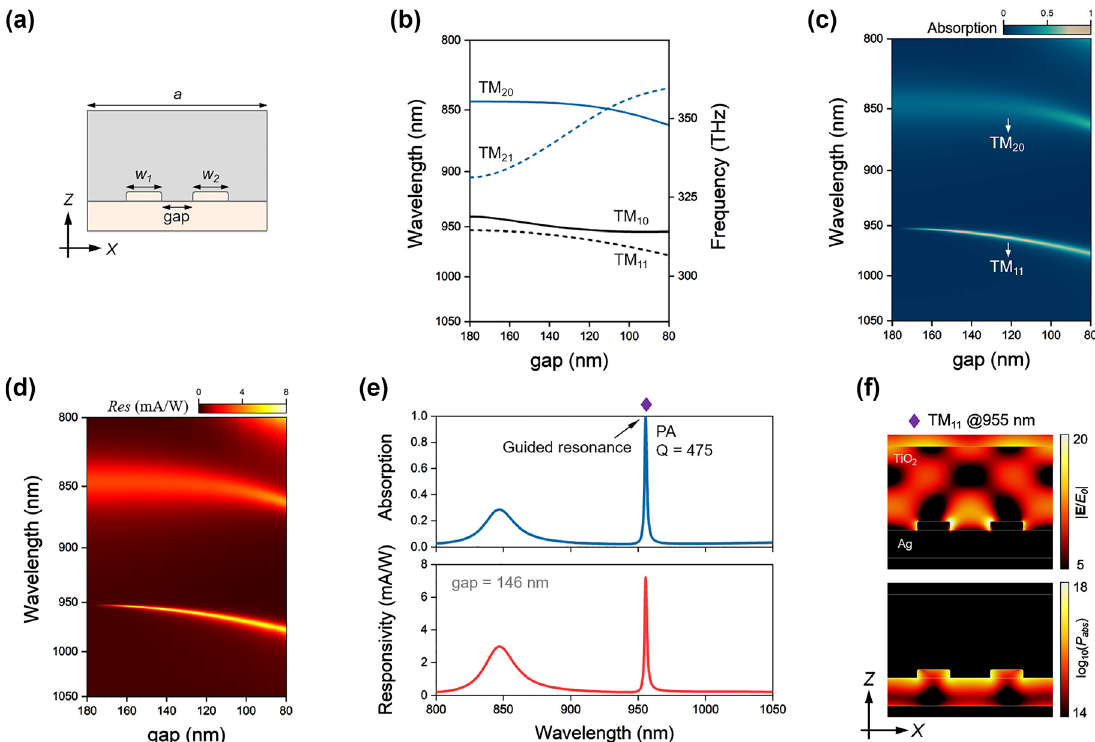
Figure 4: Narrow-band HEPD driven by guided resonance. (a) Schematic diagram of the unit cell of plasmonic structure when a disturbance is introduced (gap ≠ 180 nm or w 1 ≠ w 2 ). Here, a is 600 nm. (b) Eigenfrequencies of plasmonic structure with different gaps. The solid (TM 10 and TM 20 ) and dashed (TM 11 and TM 21 ) lines represent unfoldedandfoldedmodes,respectively.(c)Absorptionand(d)responsivityspectraofplasmonicstructurewithdifferentgaps.(e)Absorption andresponsivityspectraofgratingstructurewithgap=146nm.(f)Electric fi eldand P abs distributionatTM 11 mode,whichismarkedasapurple diamond in e. The grating widths in b ∼ f are w 1 = w 2 = 120 nm.